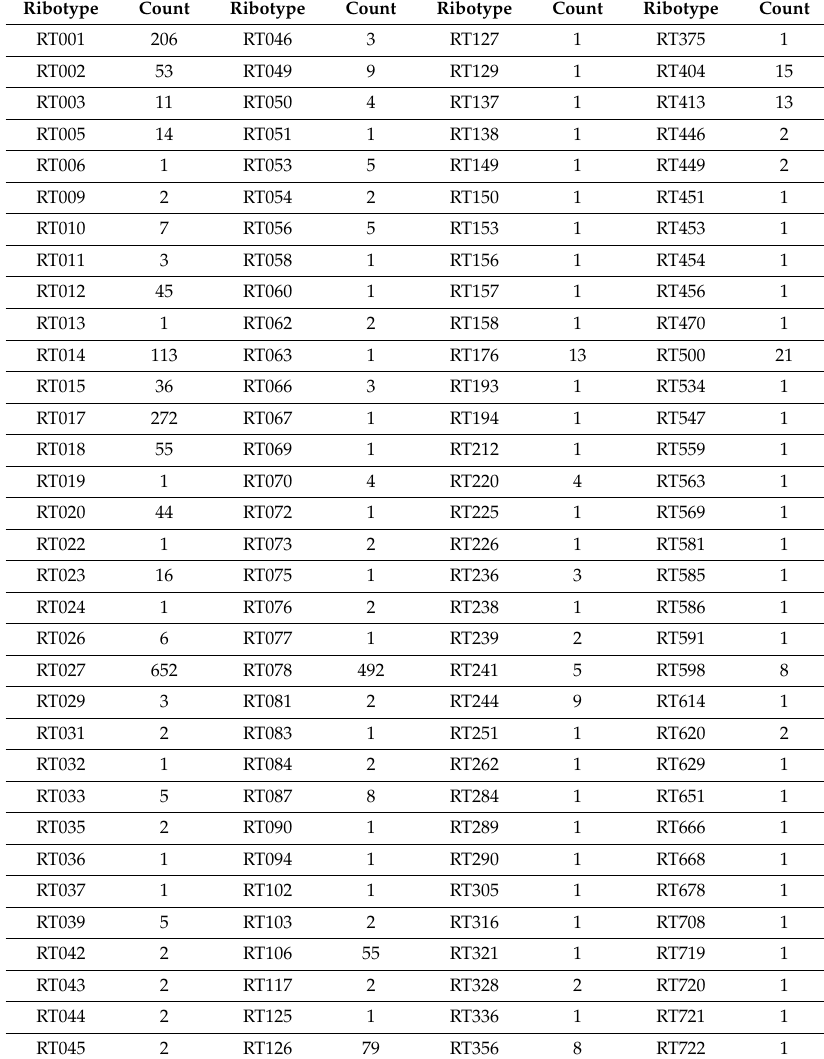
Table 3. C. di ffi cile ribotypes downloaded from the Enterobase database as a test dataset and the number of genomes included in each